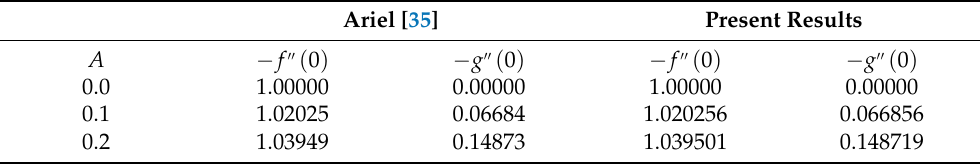
Table 1. Comparison of analytical findings with those of Ariel [35] for S = Ω = (cid:118) = Π = γ = 0. Ariel [35] Present